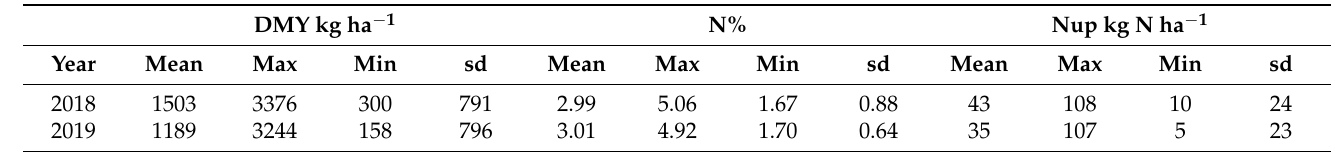
Table 5. Descriptive statistics for the response variables DMY, N%, and Nup per year (max: maximum; min: minimum; sd: standard deviation).